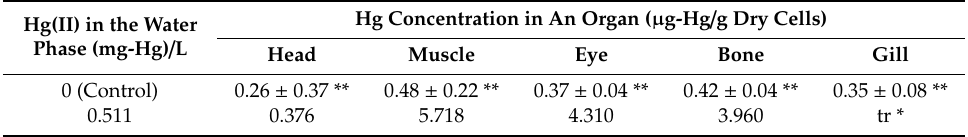
Table 2. Accumulation and its organ distribution of Hg in freshwater fish ( Oreochromis niloticus ) after exposure to water contained high concentration of Hg(II).